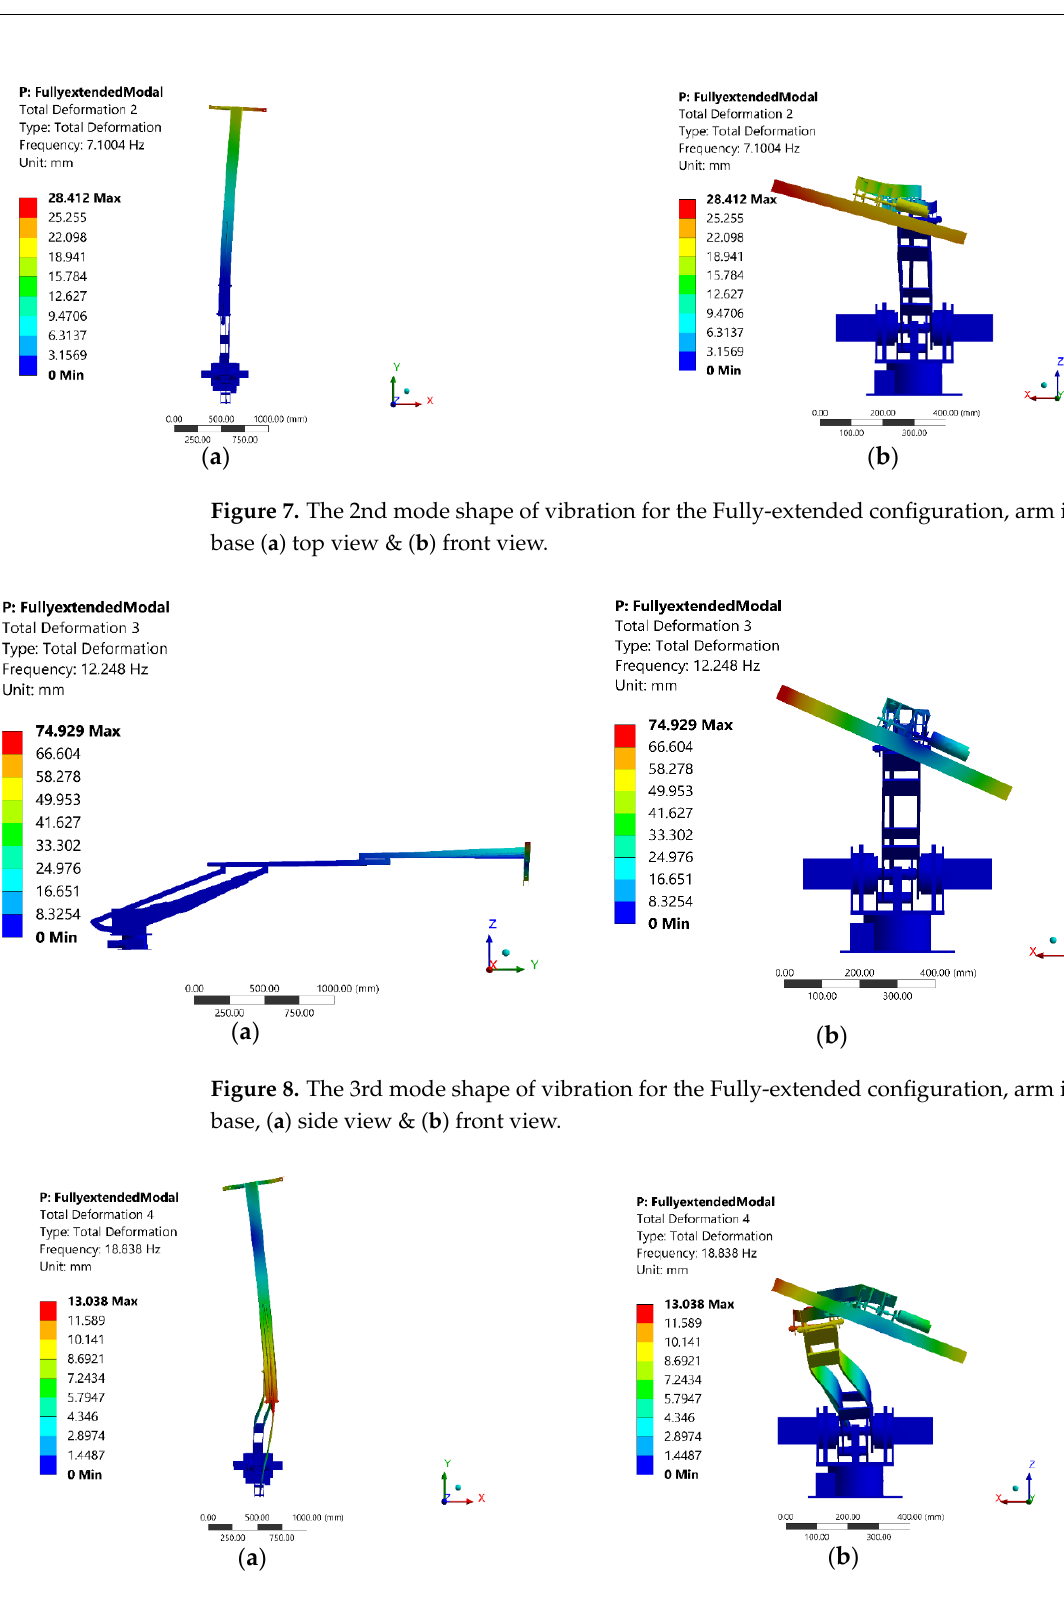
Figure 9. The 4th mode shape of vibration for the Fully-extended configuration, arm is fixed at the base ( a ) top view & ( b ) front view.